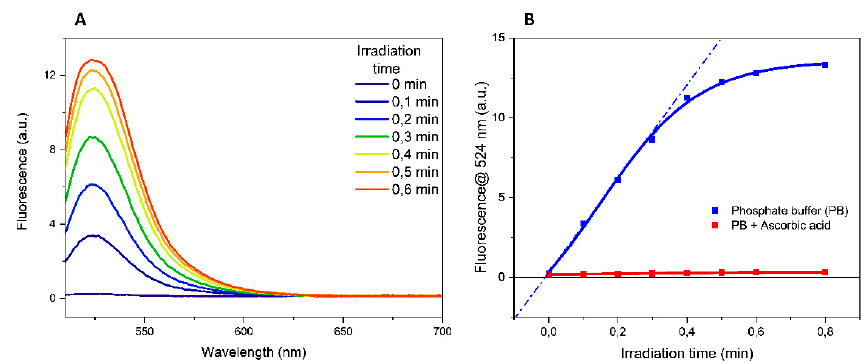
Figure 2. ( A ) Fluorescence emission spectra of oxidized DHR-123 in 10 mM phosphate buffer, pH 7.00. ( B ) Time-courses of fluorescence emission at 524 nm of oxidized DHR-123 in tested buffer so- lutions. A DMSO stock solution of DHR-123 was diluted in tested buffer obtaining a 3.17 µM solu- tion (DMSO percentage less than 0.05%). Solutions were irradiated using UV-C lamps in a BioLink 254 photoreactor. Fluorescence spectra were recorded after excitation at 505 nm with a slit of 4 nm. Table 2. Oxidation rate and doubling time (dt) values of DHR-123 conversion to fluorescent Rh-123 in tested buffer solutions. rate that corresponds to the slope of the tangent to the time-course curves (Figure 2B and Buffer PB TRIS HEPES MOPS Rate dt Rate dt Rate dt Rate dt min − 1 · 10 3 min min − 1 · 10 3 min min − 1 · 10 3 min min − 1 · 10 3 min alone 30.40 ± 0.08 0.21 ± 0.08 BSAff 38.53 ± 0.02 HEWL 48.91 ±